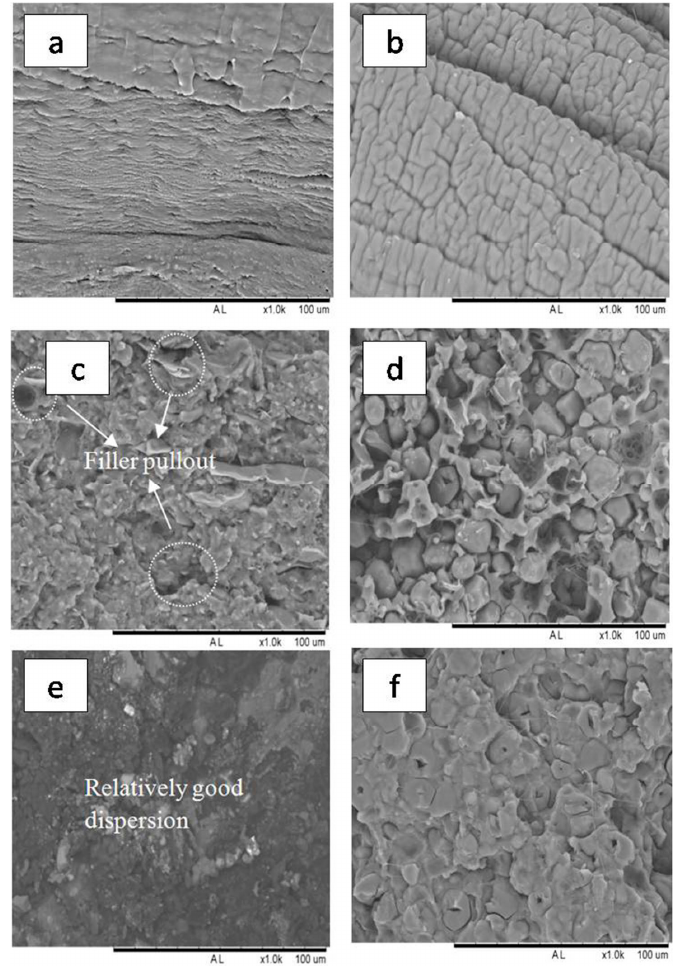
Figure 6. Fractured morphology of ( a ) PBS, ( b ) PBAT, ( c ) TPRH48/12, ( d ) TPS48/12, ( e ) TPRH36/24, and ( f ) TPS36/24.